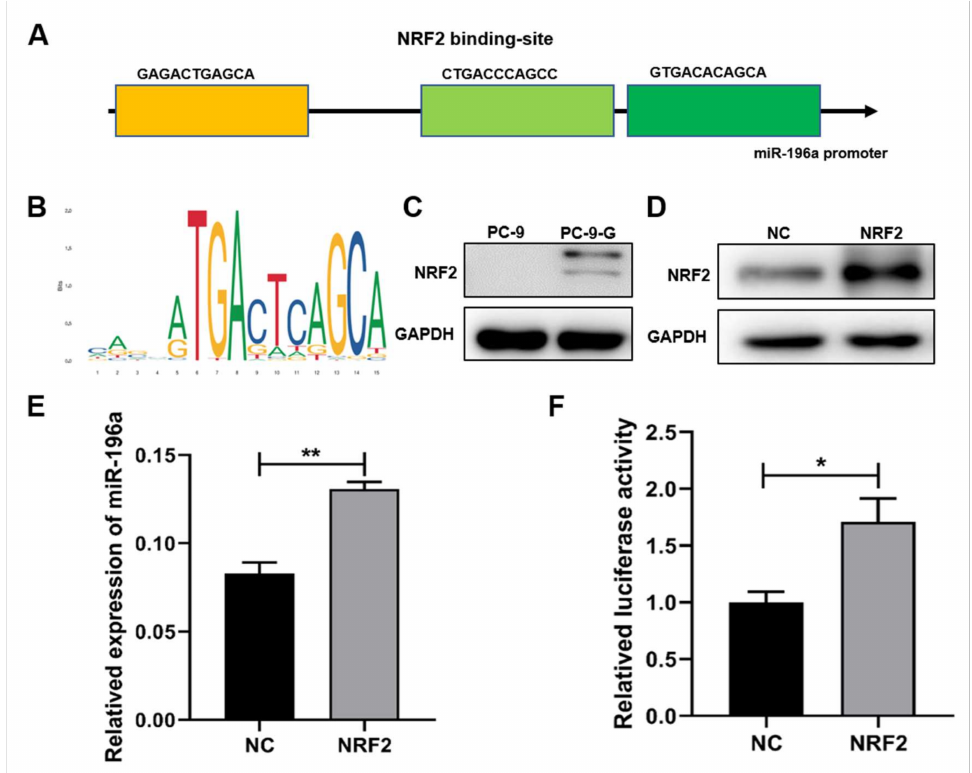
Figure 3. NRF2 upregulated miR-196a expression at transcriptional level. ( A ) The position and sequence of NRF2 binding to miR-196a promoter were predicted using Jasper database. ( B ) Tran- scriptional regulatory motif of NRF2 in gene promoter region. ( C ) The protein expression levels of NRF2 were detected in PC-9 and PC-9-G cells by Western blot. ( D ) The protein expression of NRF2 in NRF2 overexpression cells by Western blot. ( E ) The expression levels of miR-196a were tested in NRF2 overexpression cells by qRT-PCR. ( F ) The 2 kb upstream sequence of miR-196a transcription start site was cloned into PGL3 vector, which co-transfected with NRF2 overexpression vector in 293T cells. The potential NRF2 binding regions in miR-196a promoter were tested by the luciferase activities. Data represent the mean ± S.D. of 3 independent experiments where * indicates significant difference at p < 0.05, ** at p <